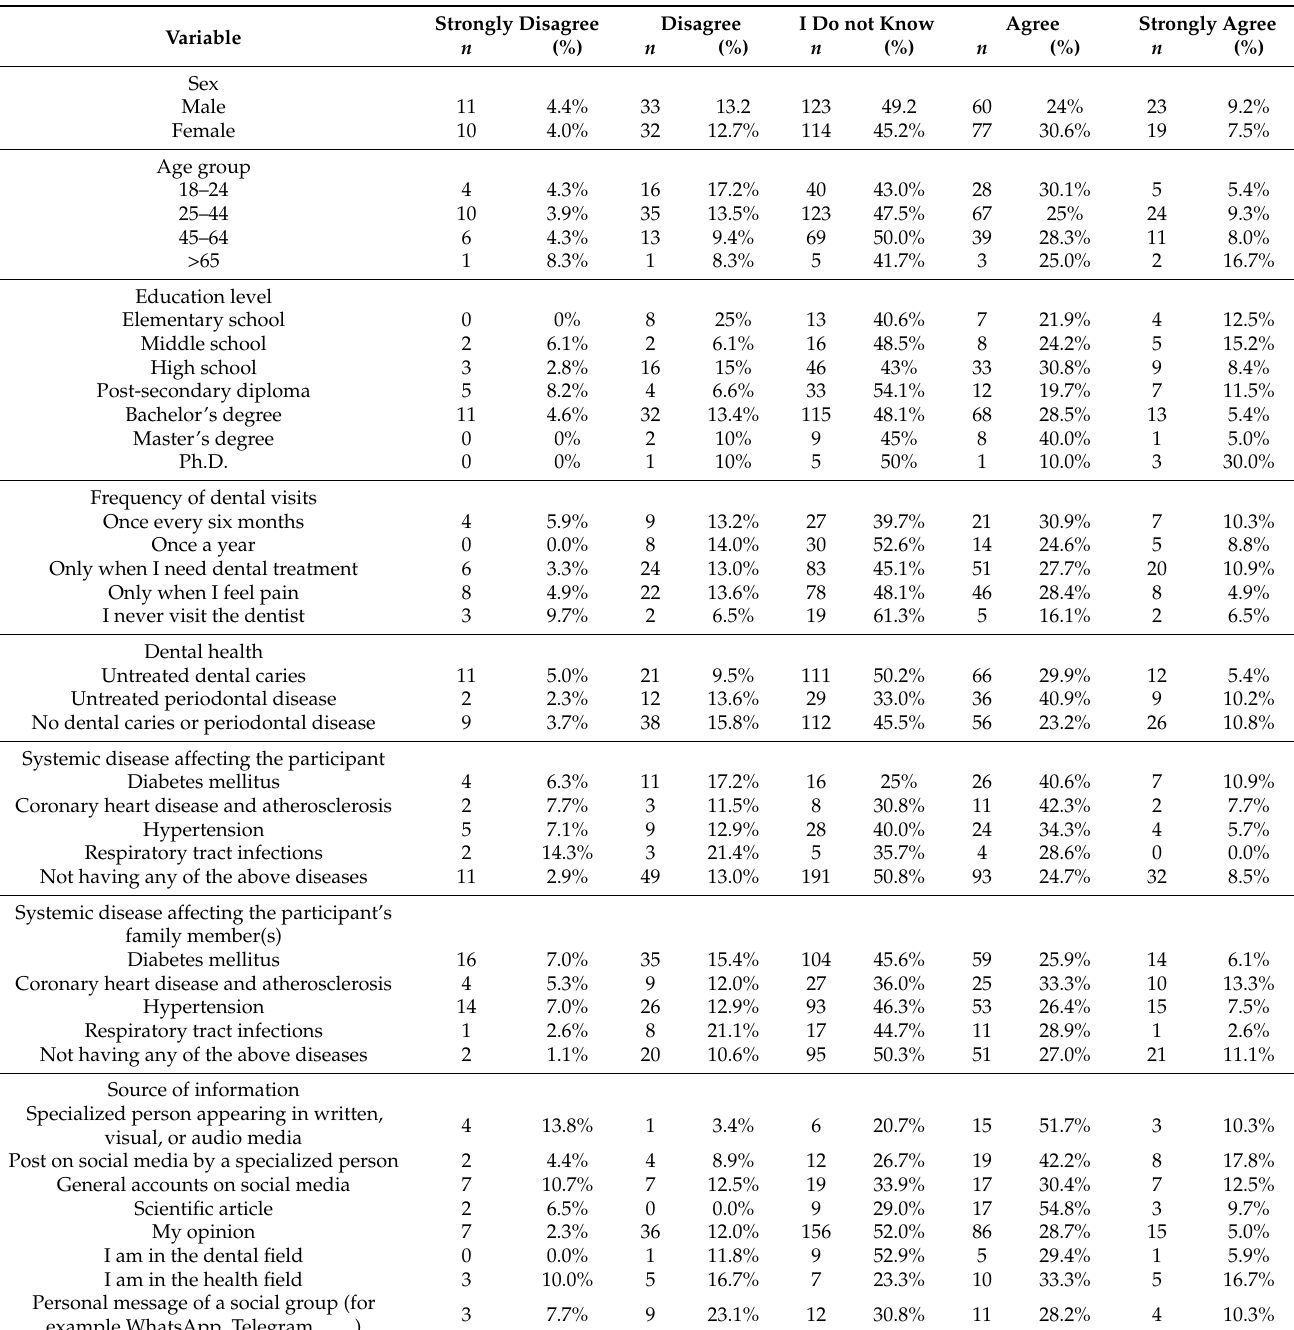
Table 5. Awareness about the association between periodontal disease and diabetes mellitus dis- tributed by various